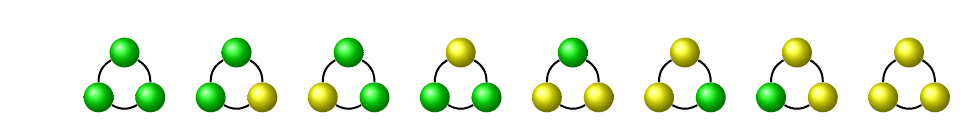
Fig. 2. Necklaces with 3 beads in 2 colours. The first and last are monocoloured necklaces. The other multicoloured necklaces are divided into 2 parts: those with one yellow bead and those with two yellow beads. Multicoloured necklaces in each part can cycle only among themselves. Note that, for 3 beads, each part consists of 3 necklaces. Hence the number of multi-2-coloured necklaces with 3 beads (which is 2 3 − 2 = 8 − 2 = 6 ) is divisible by 3. Take p elements from q with repetitions in all ways, that is, in q p ways. The q sets with ele- ments all alike are not changed by a cyclic permutation of the elements, while the remaining q p − q sets are permuted in sets of p [when p is prime]. Hence p divides q p − q